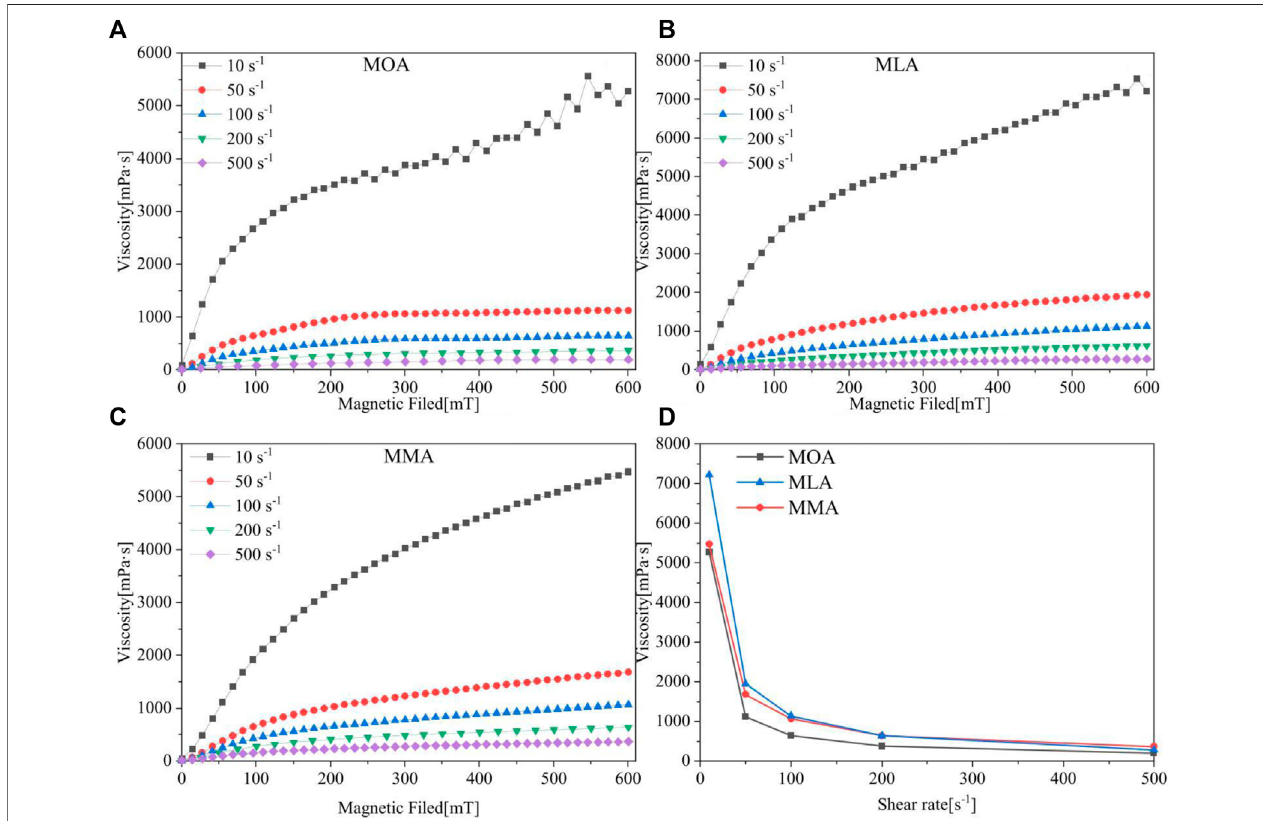
FIGURE 8 | Viscosity-magnetic fi eld images of (A) MOA, (B) MLA, and (C) MMA. (D) Maximum magnetic fi eld limit viscosity-constant shear rate comparison images of three magnetic fl uids.